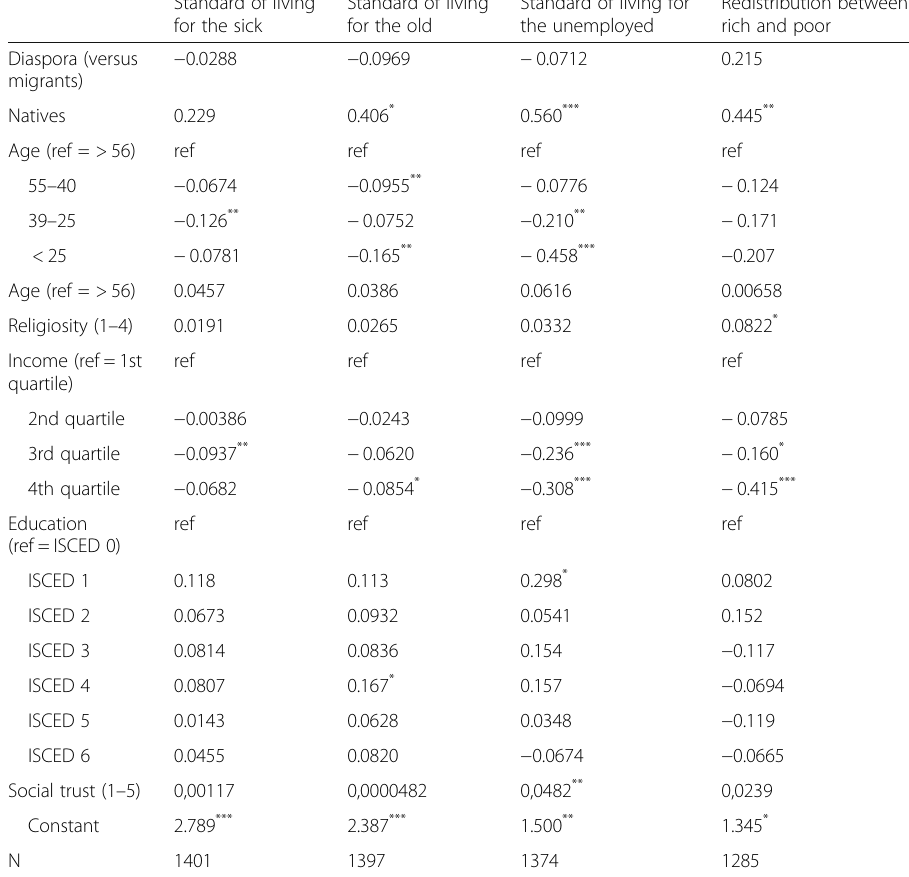
Table 2 Fixed effects regression models on attitudes to government responsibility.